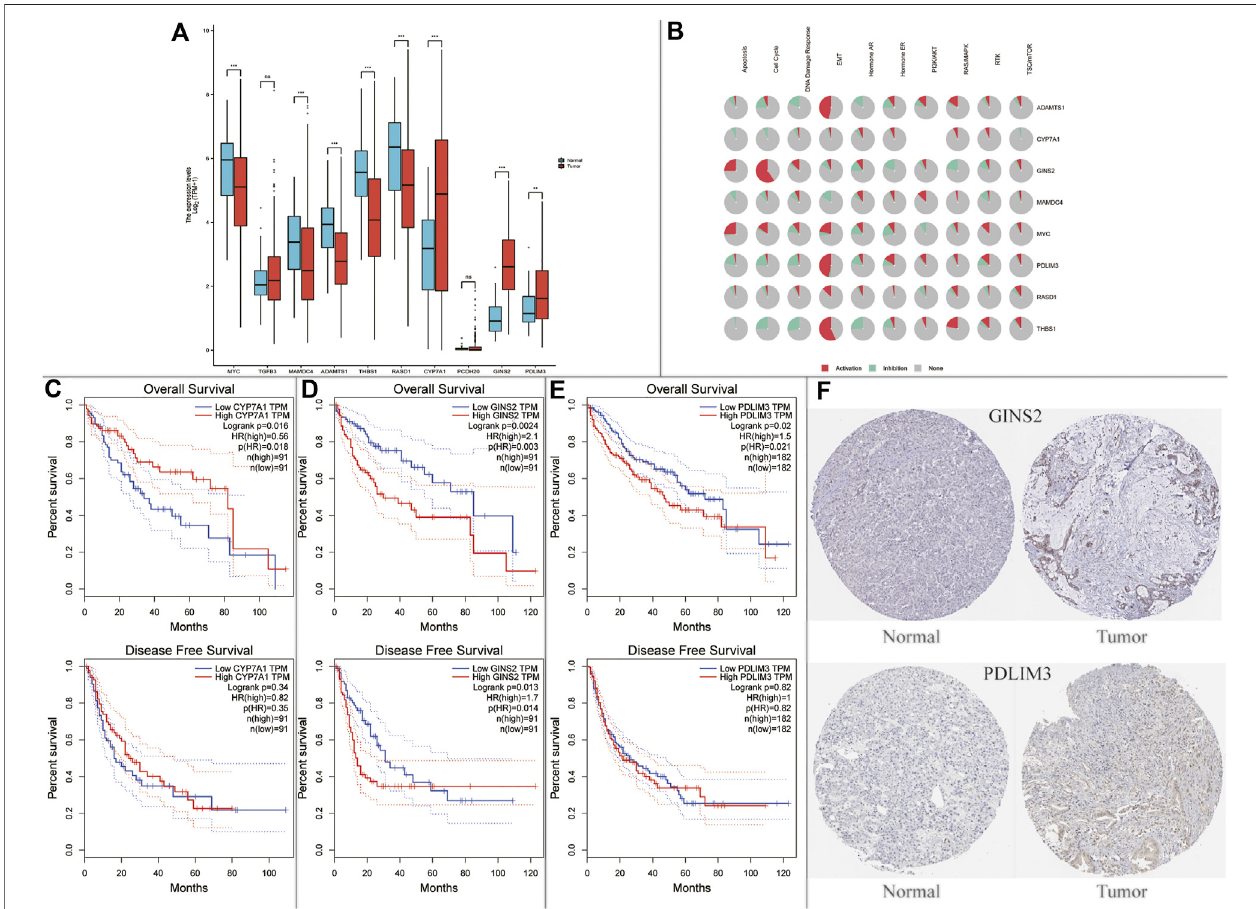
FIGURE 6 | Expression and survival analysis of the NAFLD ’ s hub genes in hepatocellular carcinoma (HCC). (A) Hub genes in NAFLD were dysregulated in hepatocellular carcinoma (ns, not signi fi cant; * p < 0.05; ** p < 0.01; *** p < 0.001); (B) Enriched pathways of 10 hub genes in the TCGA database. (C – E) Survival plots of CYP7A1 , GINS2 , and PDLIM3 ; (F) Protein expression of GINS2 and PDLIM3 between normal patients and HCC patients in the HPA database.